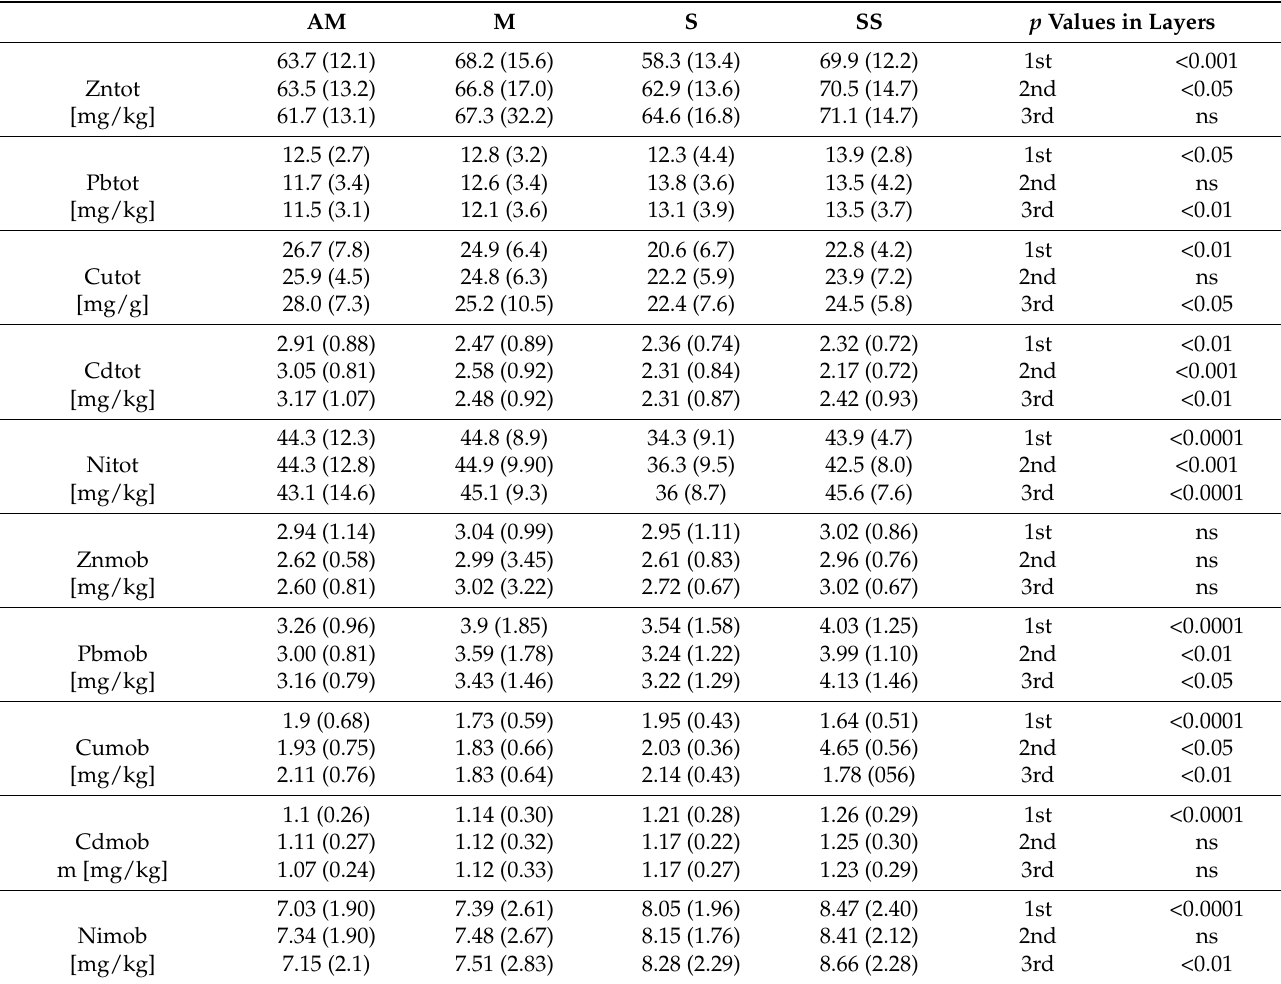
Table 2. Main statistics of heavy metals content in studied